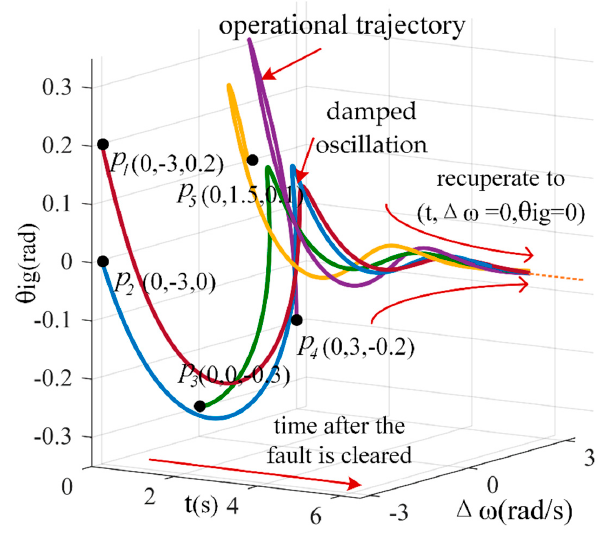
Figure 8. Operational trajectories of stable points.